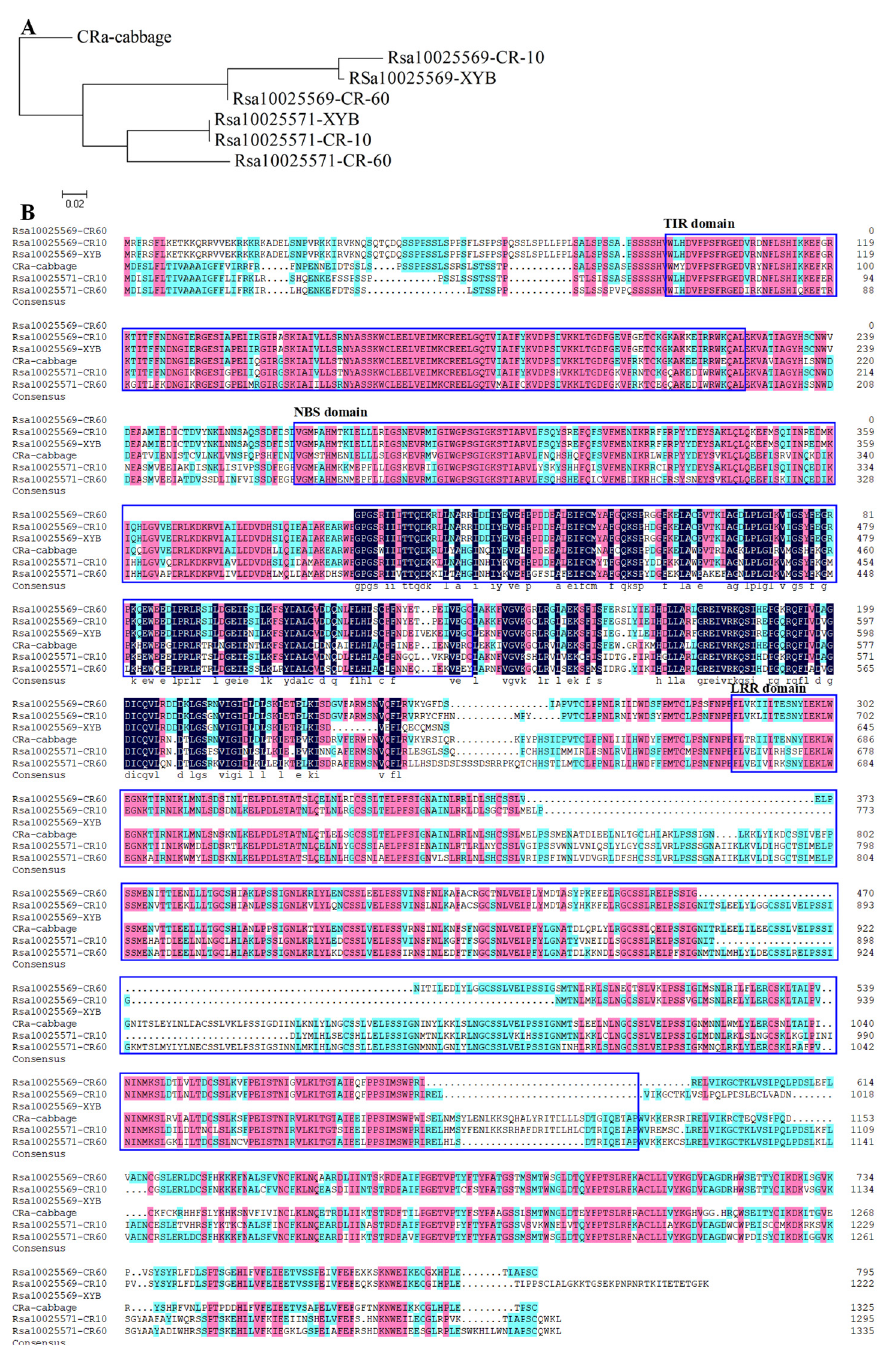
Figure 3. Phylogenetic relationships and amino acid sequence alignment of the Rsa10025569 and Rsa10025571 genes of radish. ( A ) Phylogenetic tree for Rsa10025569 and Rsa10025571 of radish lines CR-10, CR-60, and XYB36-2, and the CRa gene of Brassica rapa (GenBank: AB751516). Scale bar indi- cates nucleotide substitutions per site. ( B ) Alignment of CRa, Rsa10025569, and Rsa10025571 protein sequences in the CR-60, CR-10, and XYB36-2 reference genome. The CRa-cabbage sequences were downloaded from GenBank (accession no. BAN04700). Blue boxes indicate TIR–NBS–LRR domains. And then, Rsa10025571 was cloned, which was a tandem disease-resistance gene in the RsCRa locus. The sequence of the PCR product (4767 bp) amplified from the clubroot- susceptible lines CR-10 and CR-35 showed 100% similarity to that of XYB36-2. The simi- larity between the amplified sequences from the clubroot-resistant lines CR-60 and